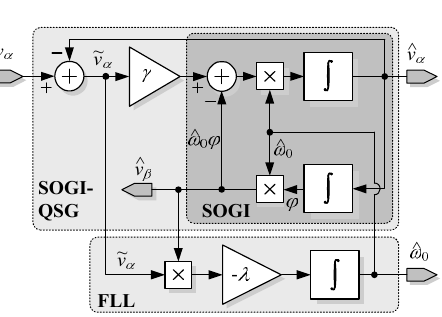
Figure 2. Block diagram of the single-phase second-order-generalized-integrator (SOGI)-based FLL scheme